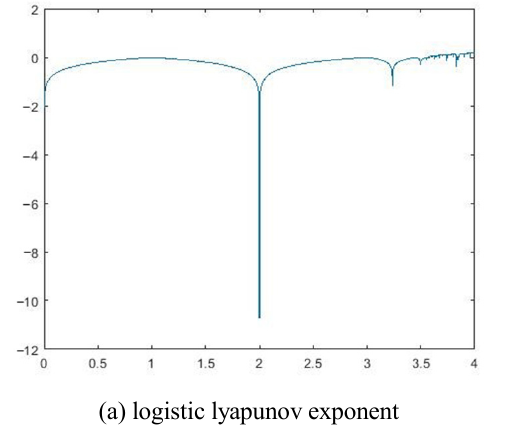
Figure 2. Lyapunov exponent. Figure 2. Lyapunov